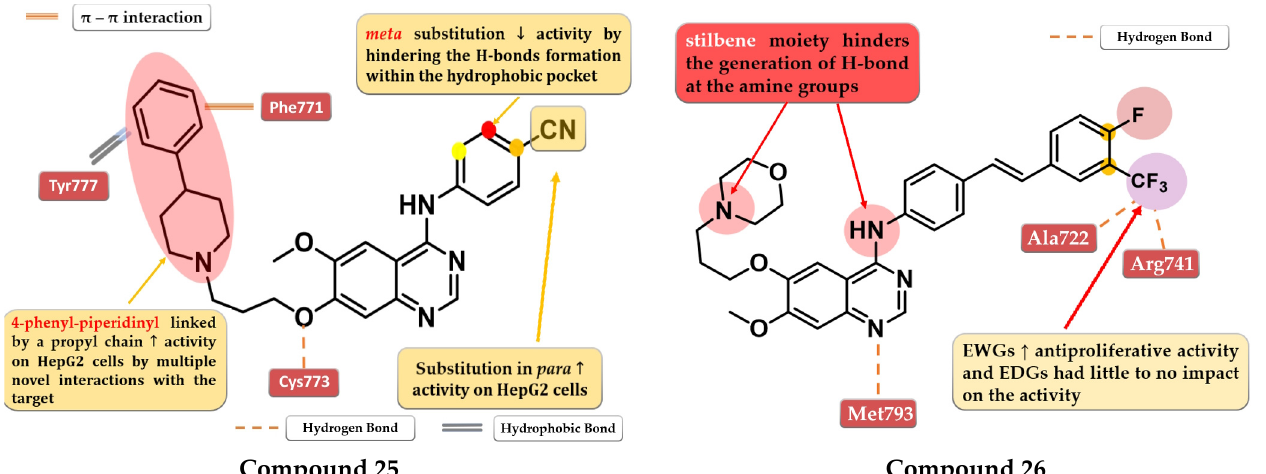
Figure 15. Structure–activity relationship and molecular docking of compound 25 in the human EGFR kinase domain (PDB ID 1M17) [124], as reported by Chang et al. [132]; structure–activity relationship and molecular docking of compound 26 in the human EGFR kinase domain (PDB ID 1XKK) [101], as reported by Wang et al.